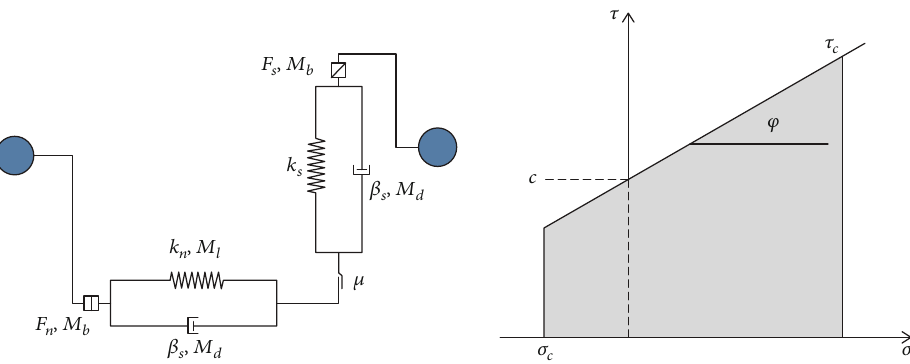
Figure 6: Model and failure criteria of contact bond.